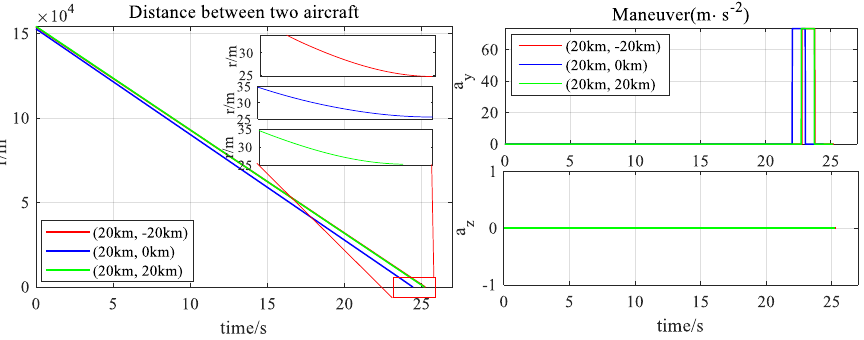
Figure 12. Evader utilizing MS-DDQN maneuvers with the three different initial relative positions ( 20km, − 20km ) , ( 20km,0km ) , and ( 20km,20km ) in the initial inertial coordinate system.